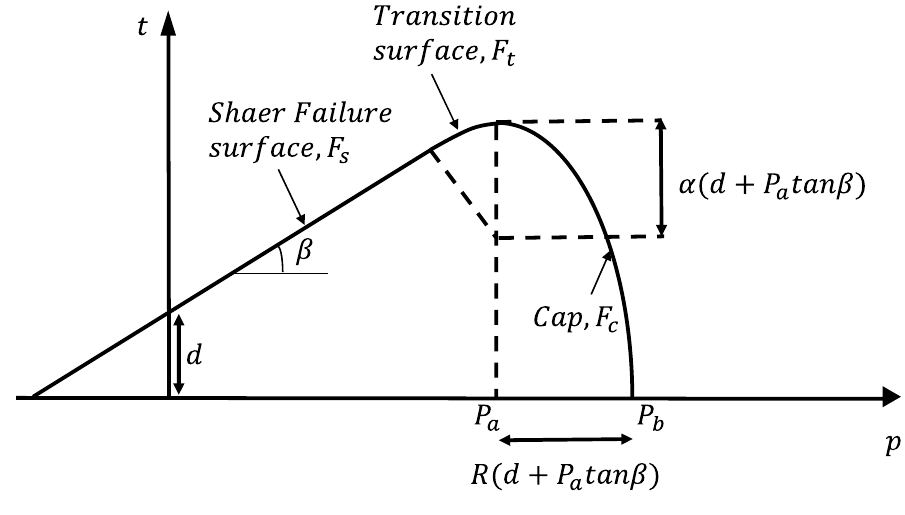
Figure 2. Yield surfaces of the MDPC model.